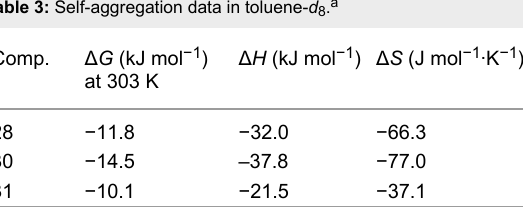
Table 3: Self-aggregation data in toluene- d 8 . a Comp.